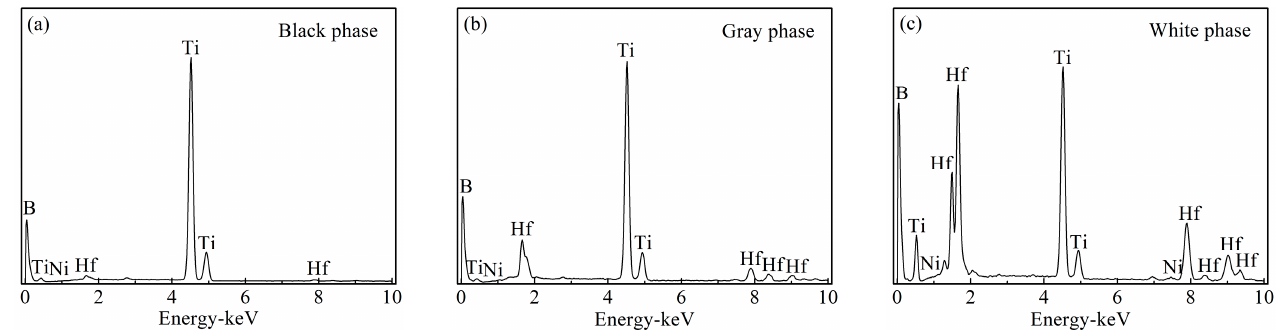
Figure 3. EDS results of the phases in TBHB before oxidation: ( a ) black phase, ( b ) gray phase, ( c ) white phase.